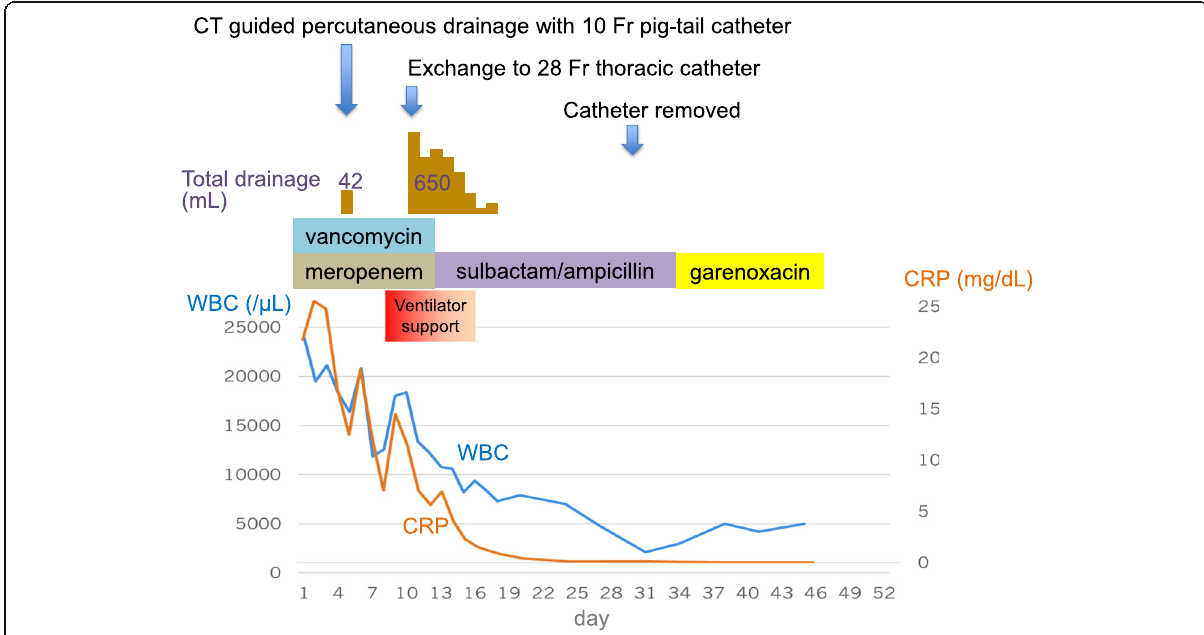
Fig. 3 Clinical course of this case. The patient ’ s respiratory condition and laboratory examination results immediately improved; he was free from